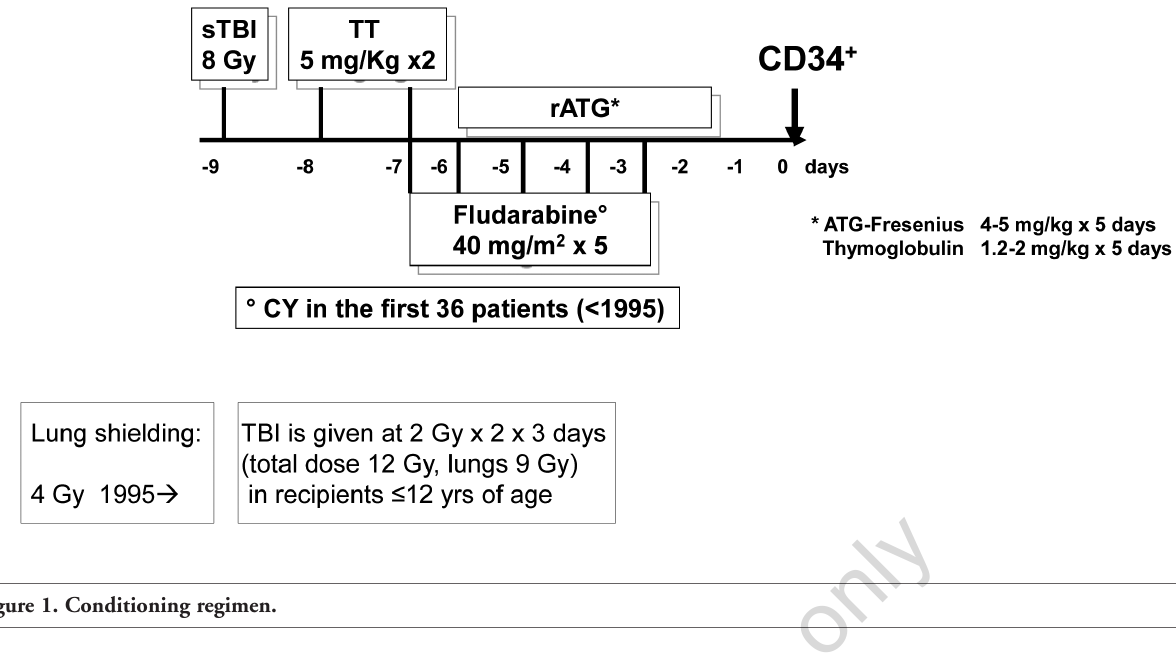
Figure 1. Conditioning regimen.